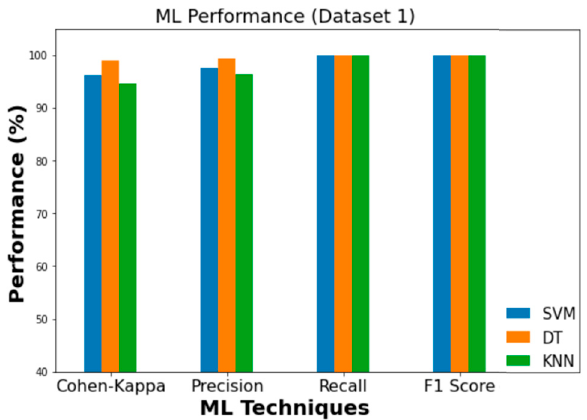
Figure 12. Performance comparison of ML (Dataset 1).